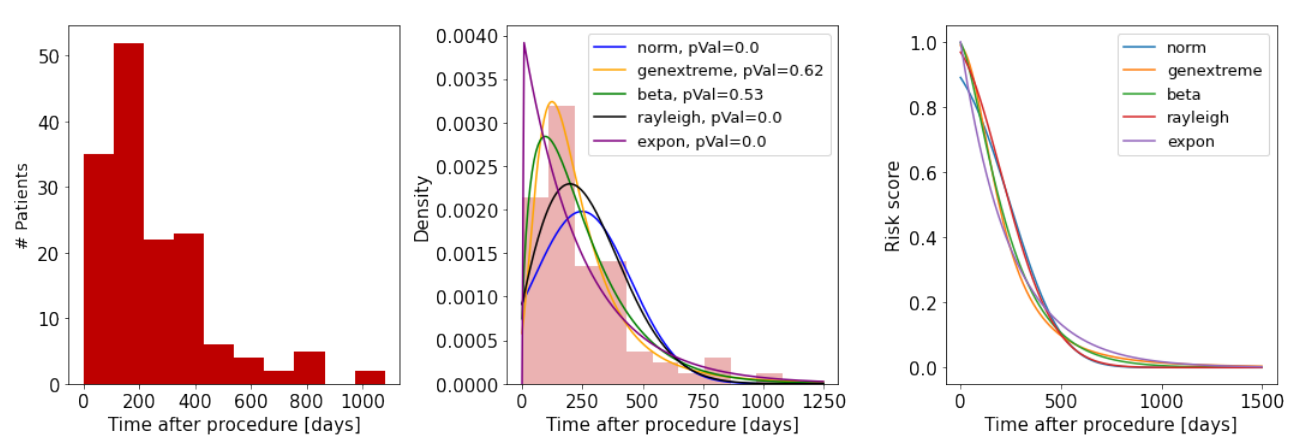
Figure 3. Fitted risk score model to TLF distribution: ( left ) histogram of time to TLF; ( middle ) candidate distribu- tions tested against the empirical distribution using the Kolmogorov–Smirnov test; ( right ) the constructed risk score for each